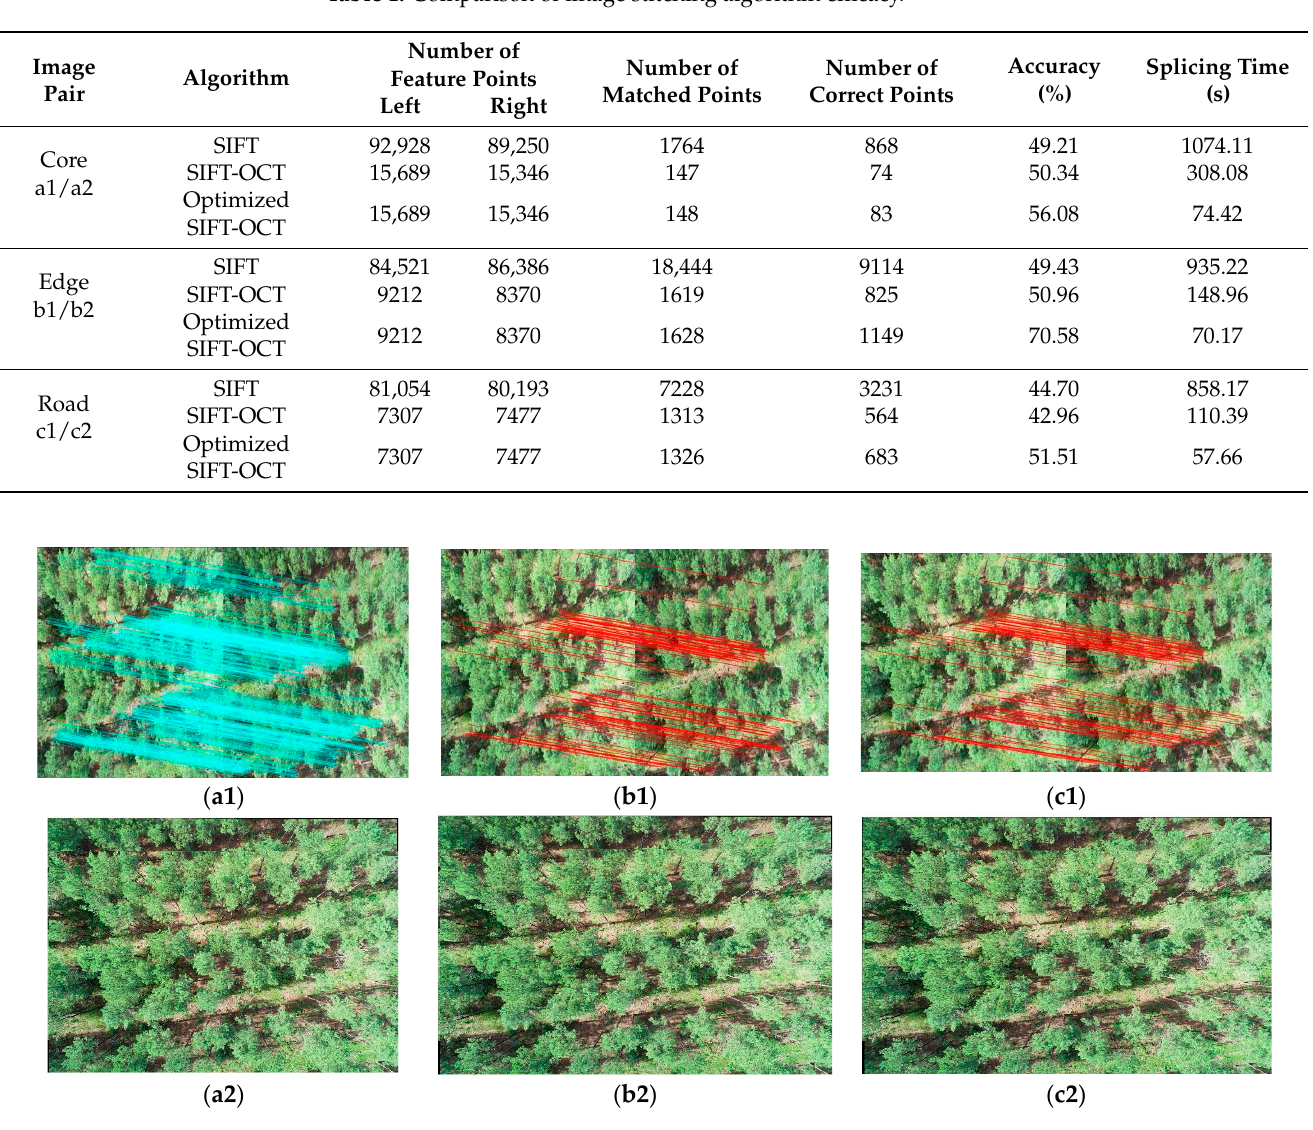
Figure 3. Feature matching and splicing effects on linear features in the forest core area. ( a1 ) Feature matching results of the SIFT algorithm. ( a2 ) Splicing effect of the SIFT algorithm. ( b1 ) Feature matching results of the SIFT-OCT algorithm. ( b2 ) Splicing effect of the SIFT-OCT algorithm. ( c1 ) Fea- ture matching results of the optimized SIFT-OCT algorithm. ( c2 ) Splicing effect of the optimized SIFT-OCT